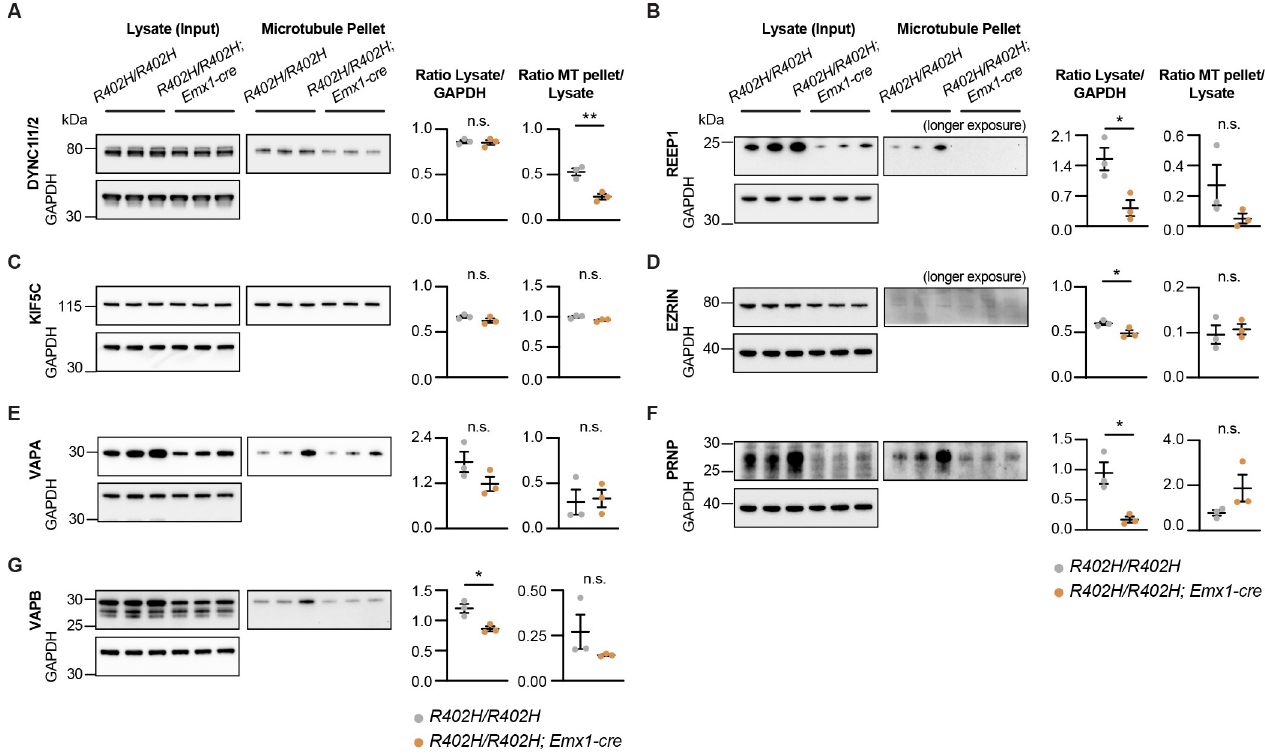
Fig 6. VAPB, REEP1, EZRIN, PRNP and DYNC1l1/2 are dysregulated in R402H/R402H; Emx1-cre mice. (A-G) Western blot analysis and quantification of the seven MAPs identified by mass spectrometry: (A) DYNC1l1/2; (B) REEP1; (C) KIF5C; (D) EZRIN; (E) VAPA; (F) PRNP; (G) VAPB. We quantified the total protein levels in brain lysates (normalised to GAPDH) and the protein present in microtubule pellets (normalised to lysate levels). Total levels of VAPB, REEP1, EZRIN and PRNP were significantly lower in the mutant lysates (n = 3, R402H/R402H vs. R402H/R402H; Emx1-cre , VAPB: P < 0.05, REEP1: P < 0.05, EZRIN: P < 0.05, and PRNP: P < 0.05). For DYNC1l1/2 total protein levels were comparable (n = 3, R402H/R402H vs. R402H/R402H; Emx1-cre P > 0.05), but there was a significant reduction in DYNC1l1/2 levels that sedimented with microtubules in R402H/R402H mutants (n = 3, R402H/R402H vs. R402H/R402H; Emx1-cre P < 0.01). Please note that GAPDH loading controls are the same for EZRIN (D) and PRNP (F); as the membrane was cut and probed with antibodies that target different sized proteins. Error bars show mean ± s.e.m. in all panels. Control animals ( R402H/R402H ) are represented in grey and homozygous mutants ( R402H/R402H; Emx1-cre ) in orange. � P < 0.05 and �� P < 0.01. All immunoblots shown are cropped images; for full-length blots see S5